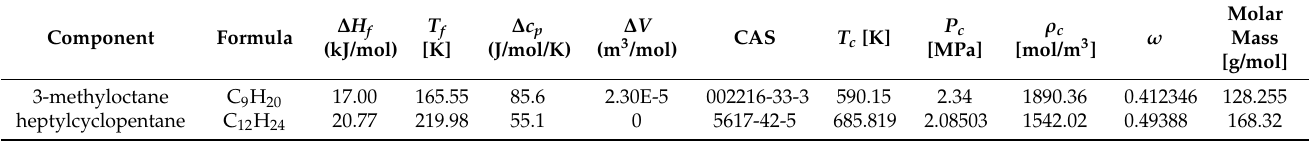
Table A1. Parameters for two discrete compounds added to ThermoFAST to enable PINA Attalla method of representative compounds, in addition to the 43 discrete compounds previously added in Attalla et al. [8]. Parameter symbols and their primary sources: ∆ H f —enthalpy of fusion [3]; T f —melting point [3]; ∆ c p —specific heat difference between liquid and solid phase [3]; ∆ V —volume change between liquid and solid phase (set to zero, or from MultiFlash 7.0) [12]; critical properties T c (critical temperature), P c (critical pressure), ρ c (critical density), and ω (acentric factor)